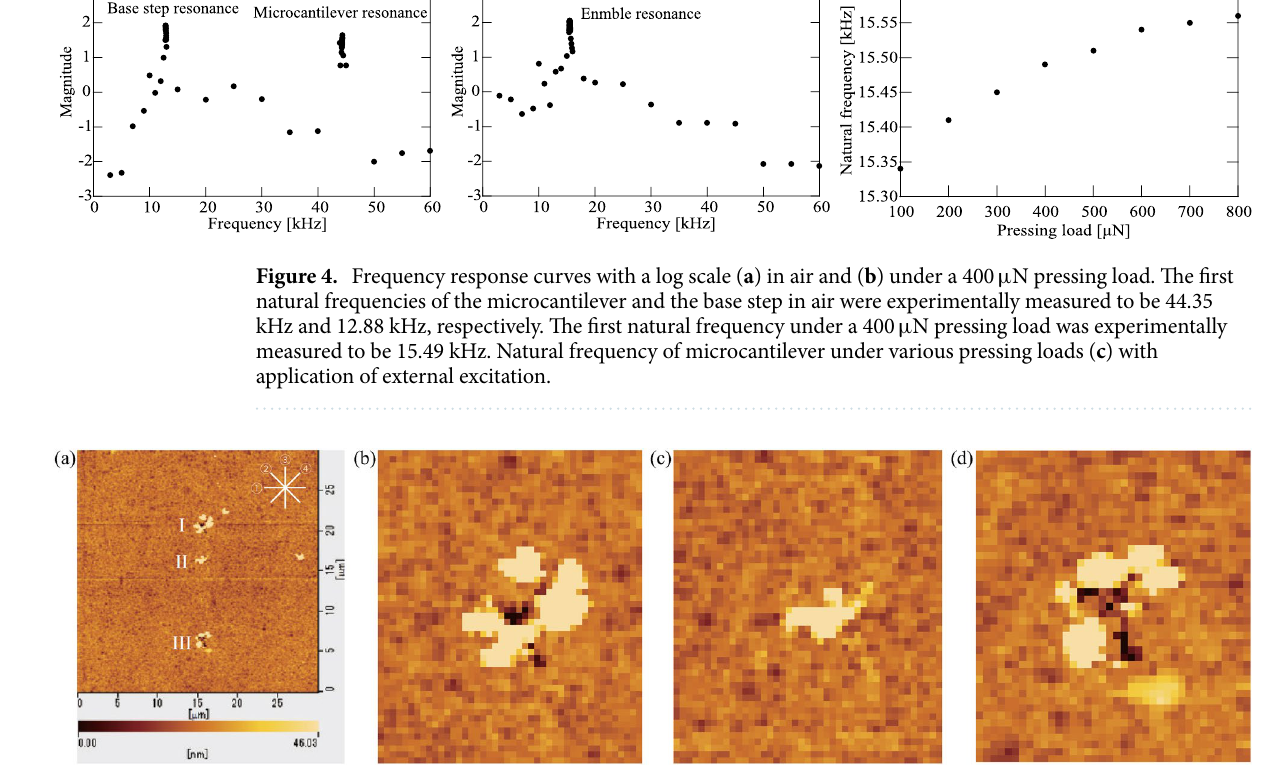
Figure 5. AFM image ( a ) shows three cutting results marked as I, II and III with the external excitation cutting method. The hole I was first cut under application of a 200 µ N pressing load at an excitation frequency of 15.41 kHz which is the natural frequency under the pressing load of 200 µ N. The cutting result II was secondly made under application of a 400 µ N pressing load at an excitation frequency of 15.41 kHz. The hole III was finally cut under application of a 400 µ N pressing load at an excitation frequency of 15.49 kHz which is the natural frequency under the pressing load of 400 µ N. Four lines 1 – 4 in the upper corner are to indicate that the (cid:31) (cid:31) locations taken for the sectional views of three cutting results shown in Fig. 1 in Appendix B and the intersecting sectional views are centered on all cutting results. ( b – d ) show the magnified depiction for the AFM image of each cutting